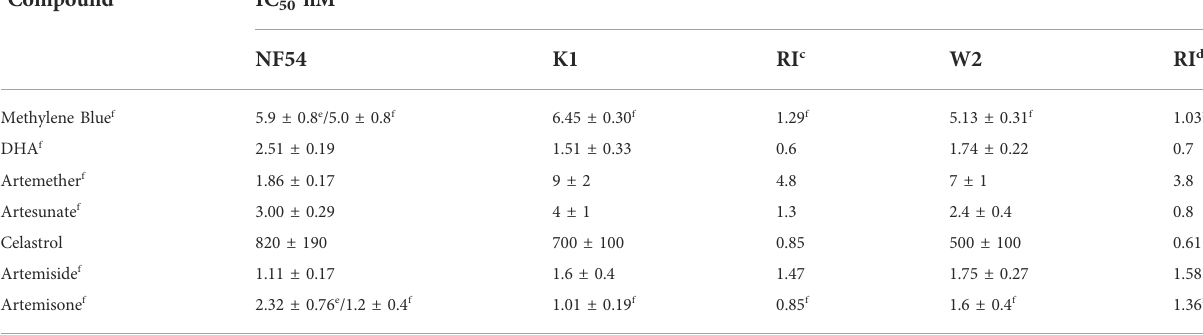
TABLE 1 Activities (nM) in vitro against asexual blood stage P. falciparum